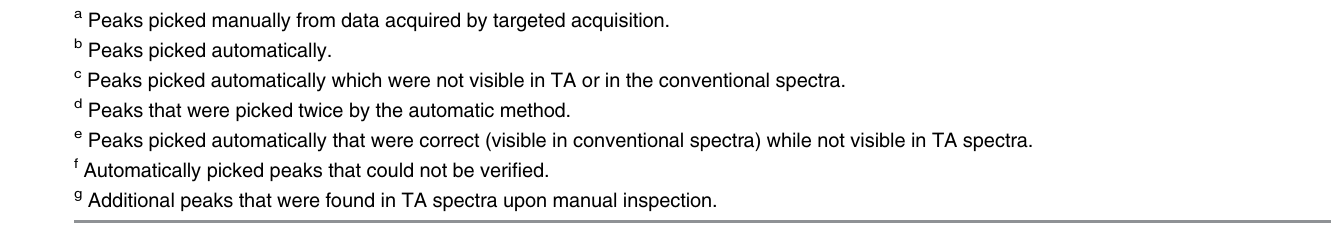
lists refer to all spectra except for the HNCO. The number of false peaks in these spectra is lower than 0.8% in total. For an additional 0.6% of the peaks the obtained data does not allow discrimination between true or false. In addition to the automated peak list, careful manual peak picking allows finding approximately 5% to 20% more peaks and in case of the weakest spectrum, HN(CA)CO, almost 30% more peaks. This was expected, since the TA peak counts did not level-off in our data set (Fig 2).